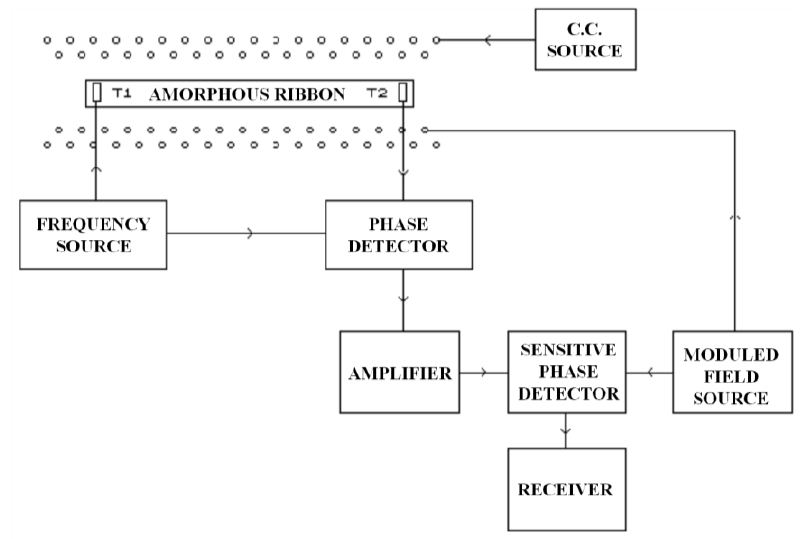
Figure 6. Sensor based on a Young modulus